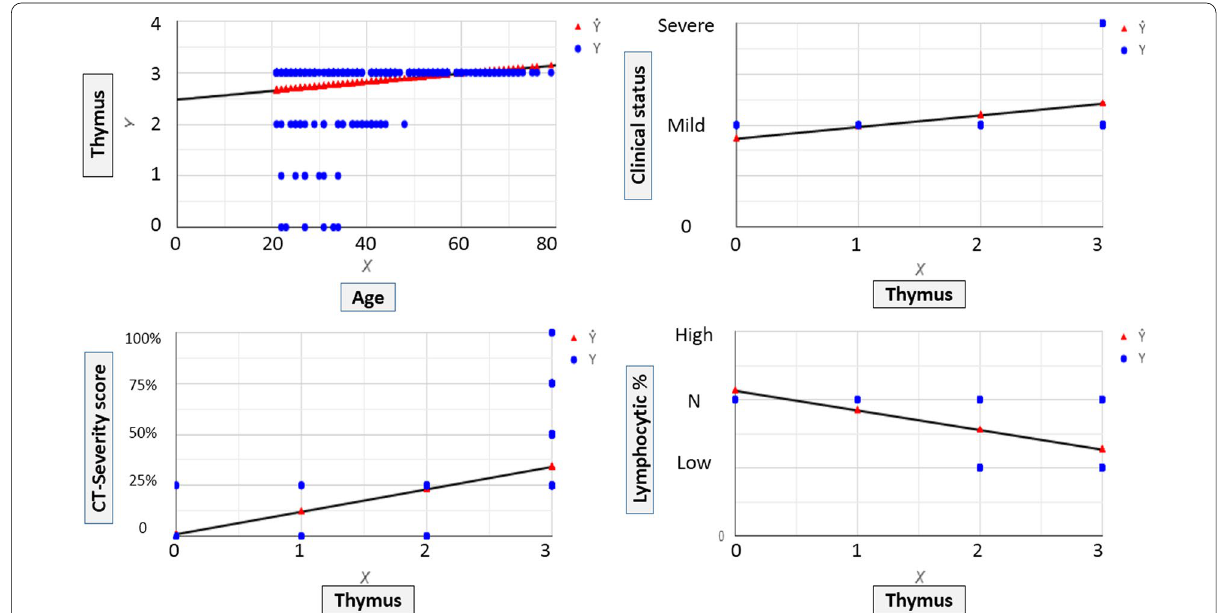
Fig. 9 Multivariate chart demonstrating the linear regression curves between the thymic CT-score and age, clinical course, lung CT-severity score, and blood lymphocytic count. Only the curve between the thymic score and blood lymphocytic count showed their reversed